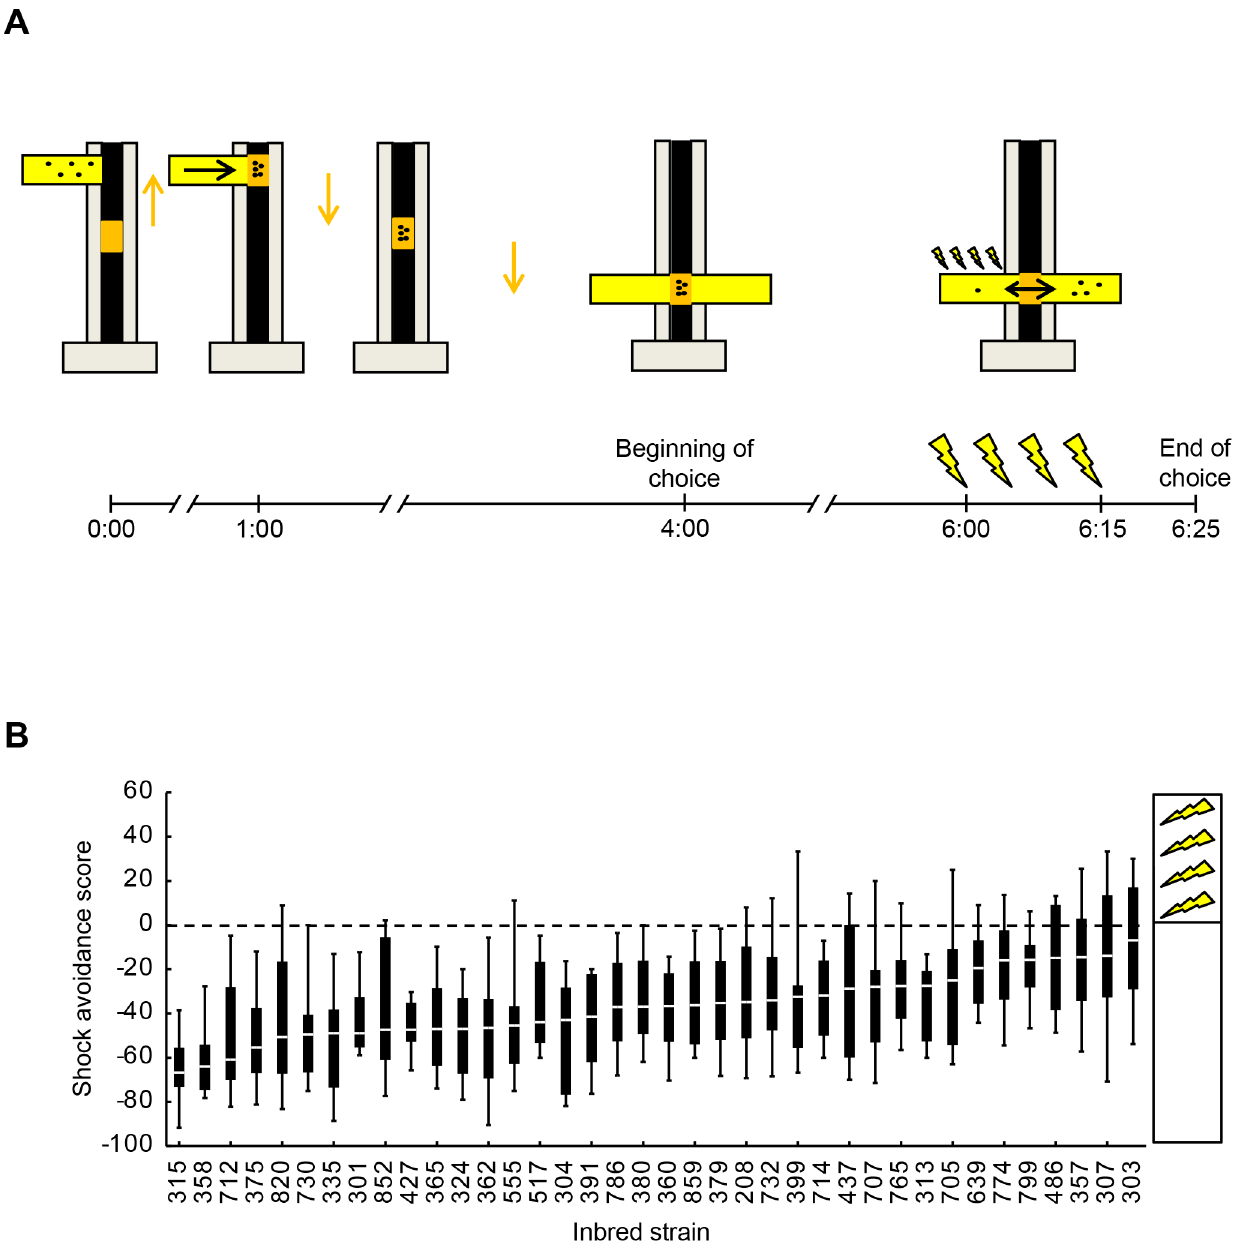
Fig 1. Shock avoidance of 38 inbred Drosophila melanogaster strains. A. For the shock avoidance assay, flies (represented by black dots) were loaded into the setup using ‘ shock tubes ’ (coloured yellow) at 0:00 min. At 1:00 min, they were transferred to a movable ‘ mid-compartment ’ (coloured orange). At 4:00 min, the mid-compartment was moved to the choice point of a maze with shock tubes as the two arms. After 2-min dispersal time, one of the maze-arms was applied with four pulses of electric shock (represented by yellow lightening symbols). 10 s after the last pulse, the maze-arms were sealed and the flies in each arm were counted to calculate a shock avoidance score. Negative values indicated avoidance of the shocked maze-arm. Orange and black arrows represent the movement of the mid-compartment and of the flies, respectively. B. The 38 tested inbred strains had significantly different shock avoidance scores. Box plots show the median as the midline, 25 and 75% as the box boundaries and 10 and 90% as the whiskers. Sample sizes were from left to right N = 32, 16, 22, 24, 24, 16, 16, 24, 26, 28, 16, 24, 28, 34, 16, 32, 24, 22, 18, 18, 22, 32, 16, 16, 24, 16, 28, 18, 22, 16, 30, 16, 20, 24, 16, 20, 32, 24.